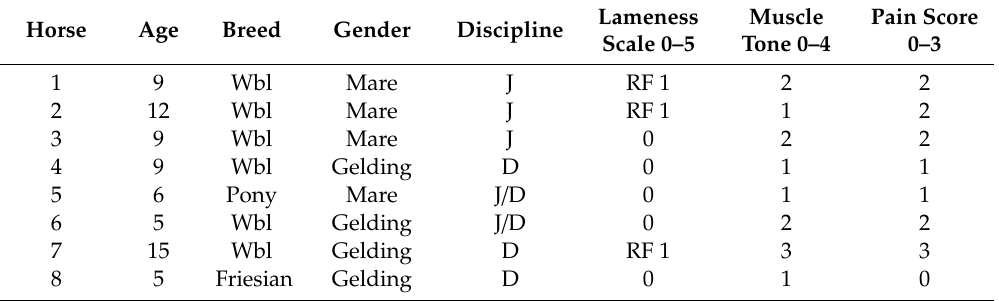
Table1. Horsesinthestudypresentedinage, breed, gender(Wbl = Warmblood), discipline(J = Jumping, D = Dressage), AAEP lameness scale (0 = lameness not perceptible / 5 = minimal weight bearing in motion and / or at rest) [27], findings in muscle tone (0 = Hypotonicity / 4 = Severe increased muscle